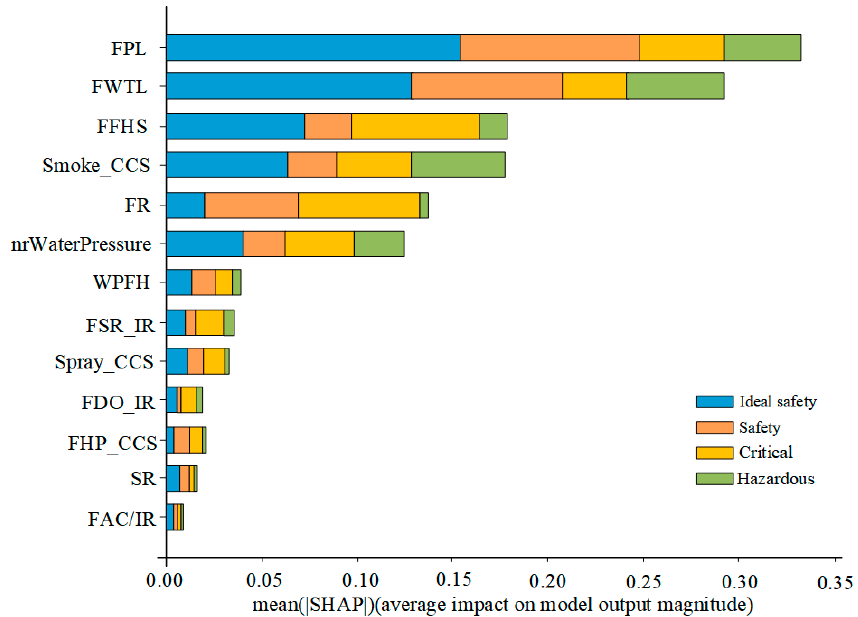
Figure 8. Confusion matrix of an RF classifier model for the equipment management database: ( a ) training set and ( b ) test set.